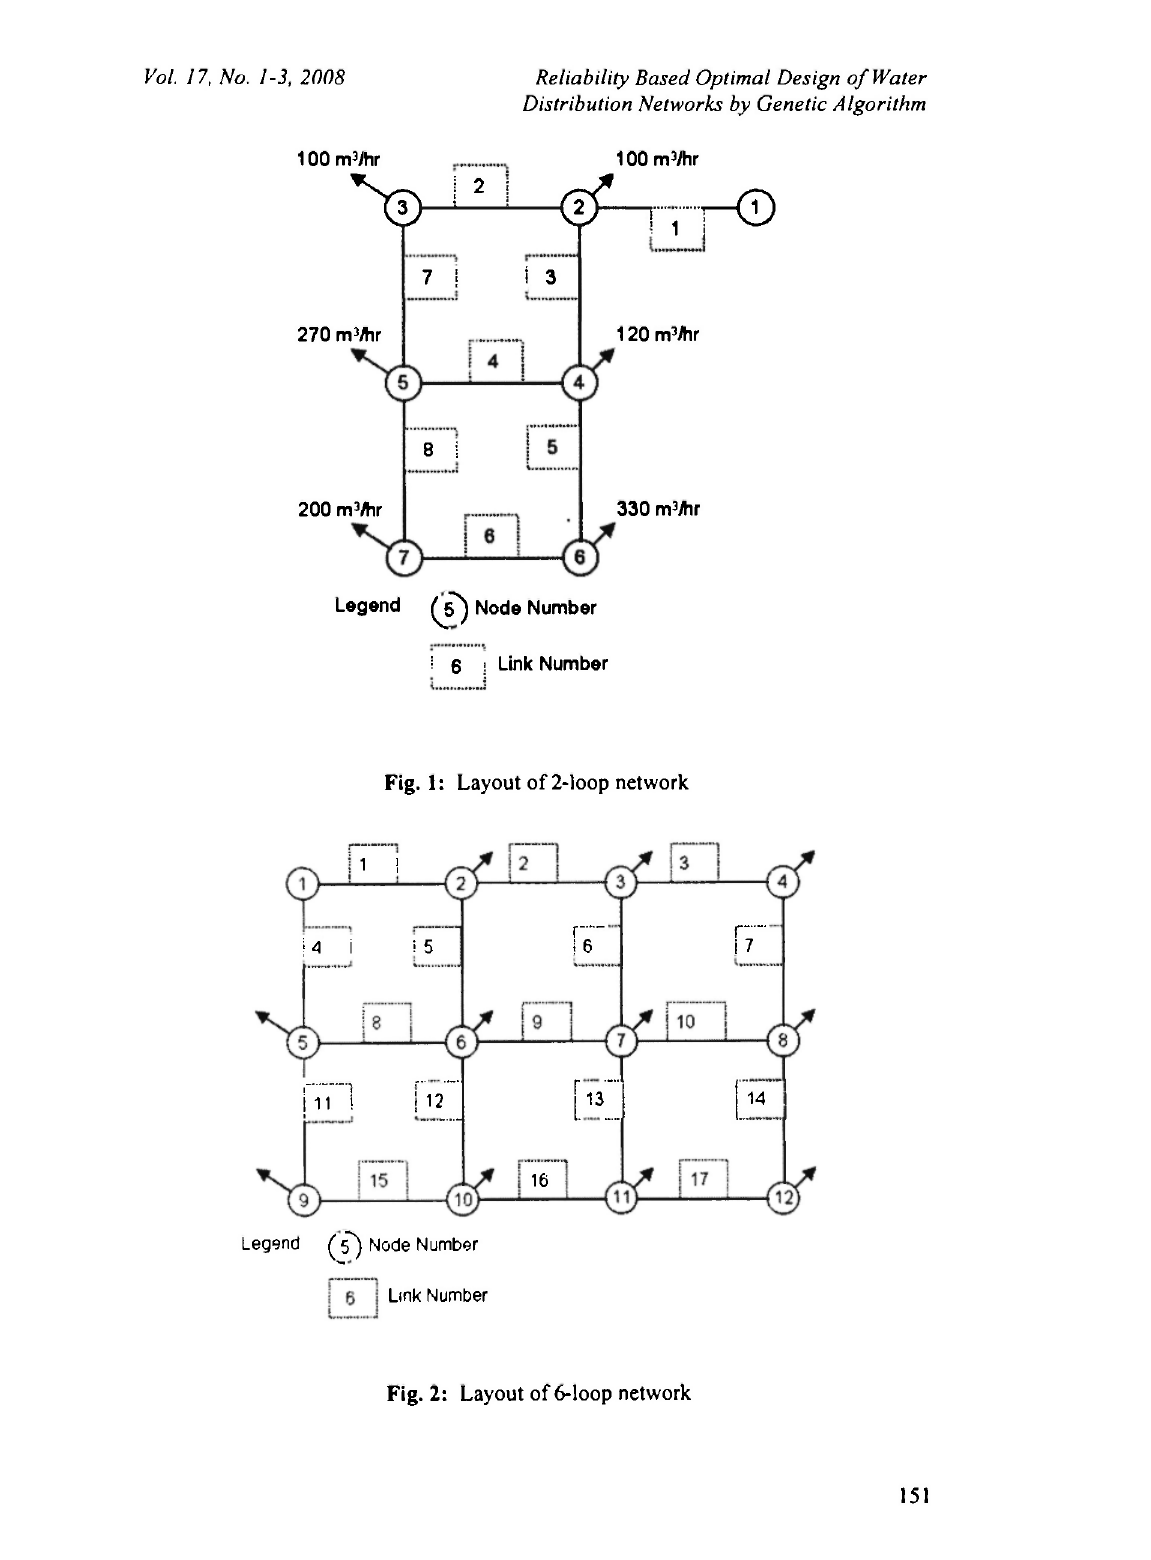
Fig. 2: Layout of 6-loop